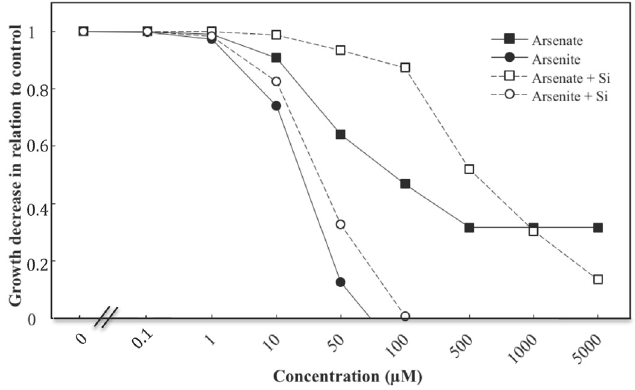
Fig. 1: Fresh weight decrease in relation to control of lettuce over five days of treatment with arsenite or arsenate in the presence or absence of 1 mM potassium silicate using modified Weibull function; ±SE is included in the figure, n =